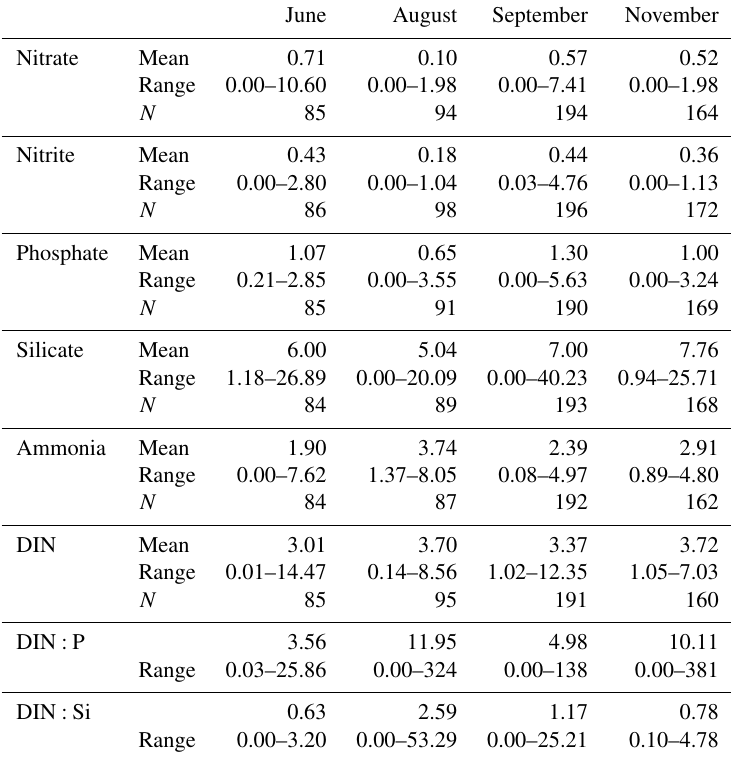
Table 2. Mean and range (µmolL − 1 ) and number of samples ( N ) for nitrate, nitrite, ammonia, phosphate and silicate in the upper 30m of the water column for all four cruises. DIN is calculated as the sum of the three nitrogen species. DIN : P and DIN : Si ratios use the values for all individual